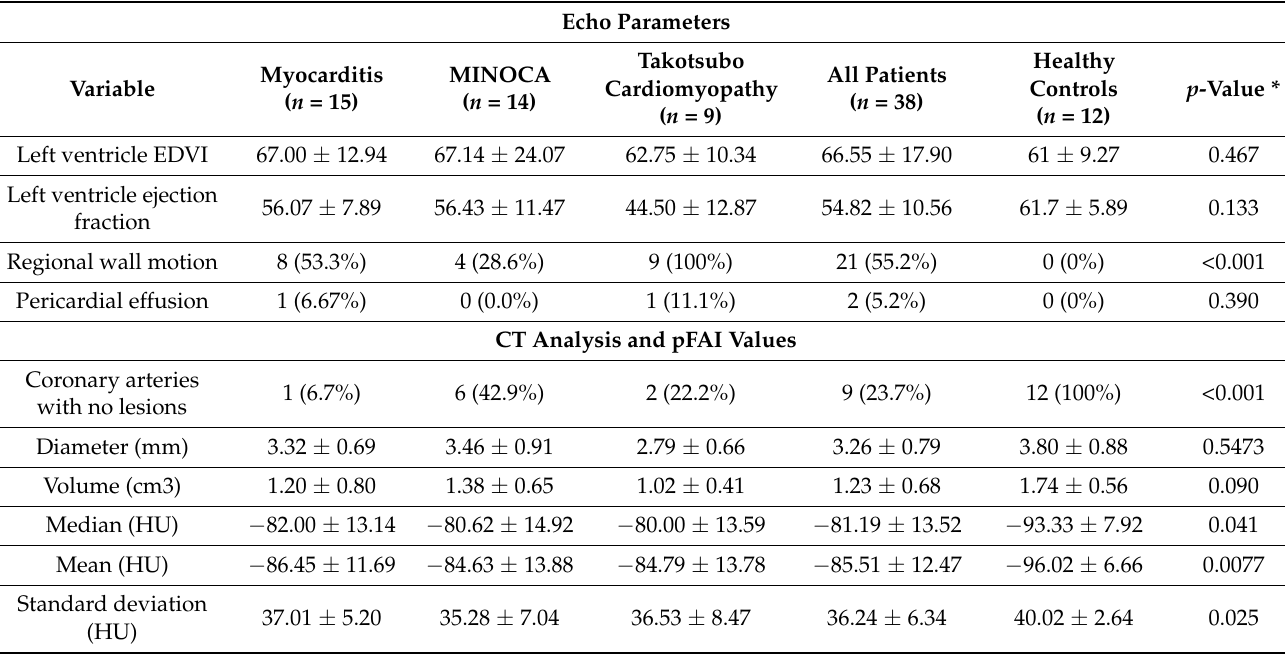
Table 2. Echocardiographic and CT parameters.